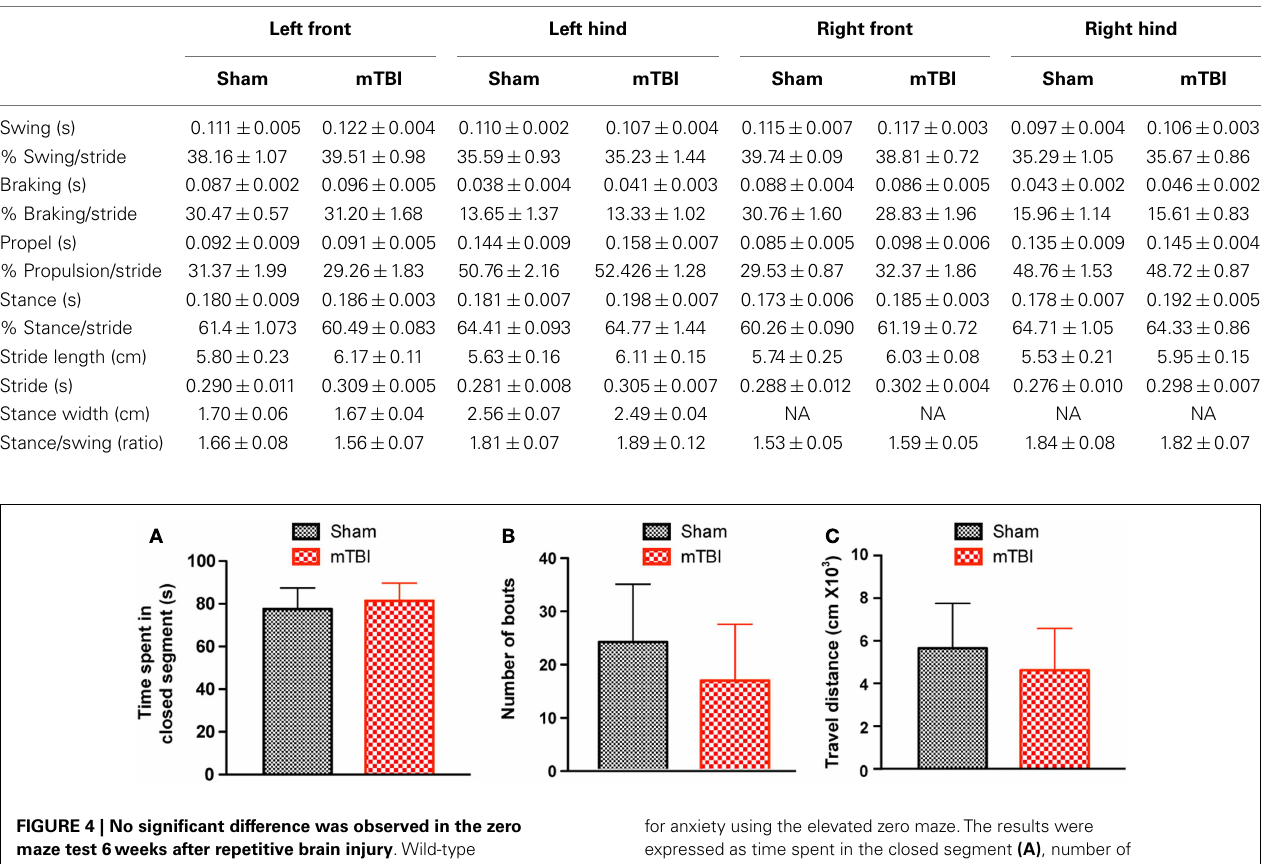
Table 1 | Gait parameters 2weeks after injury .